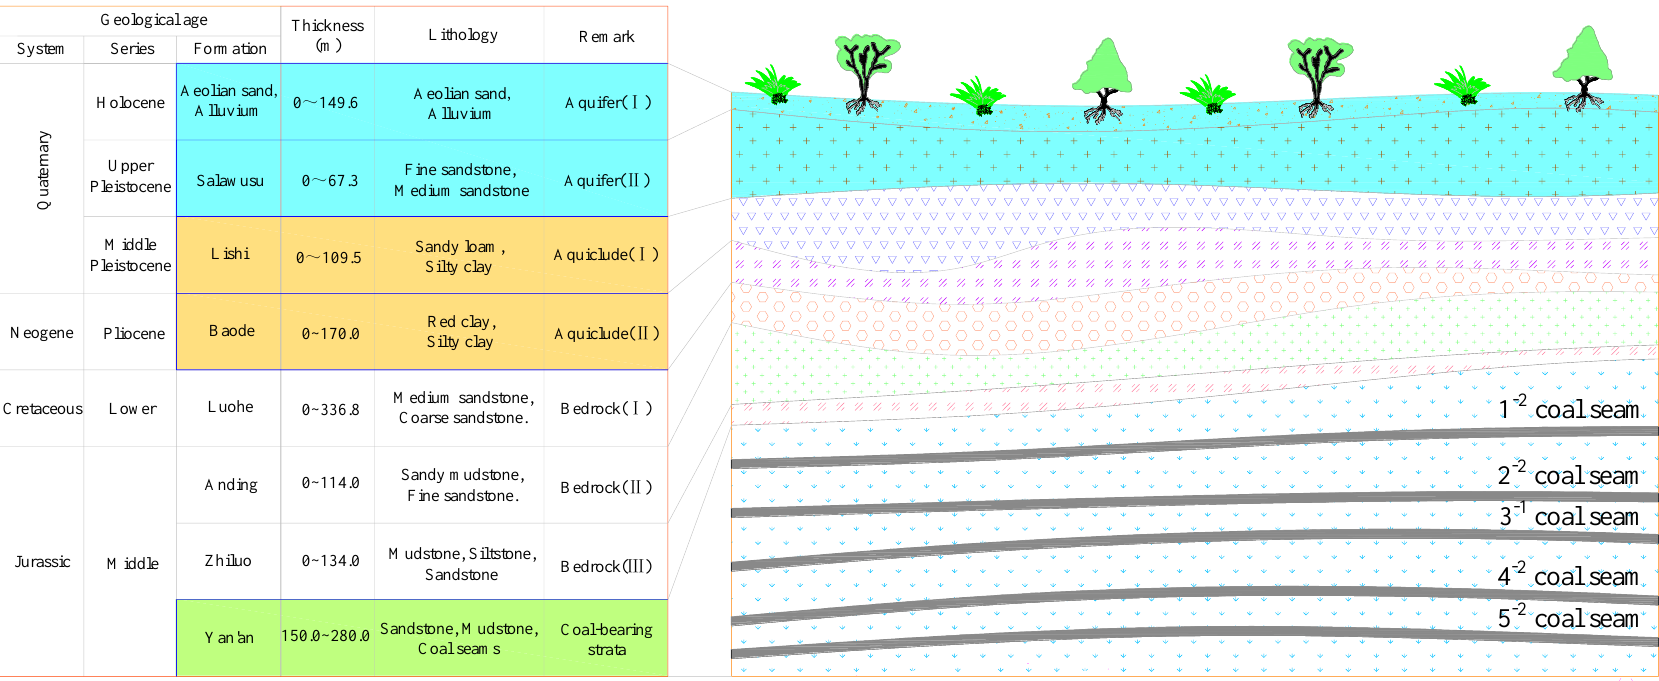
Figure 2. Stratigraphic column in Yu-Shen mining area.